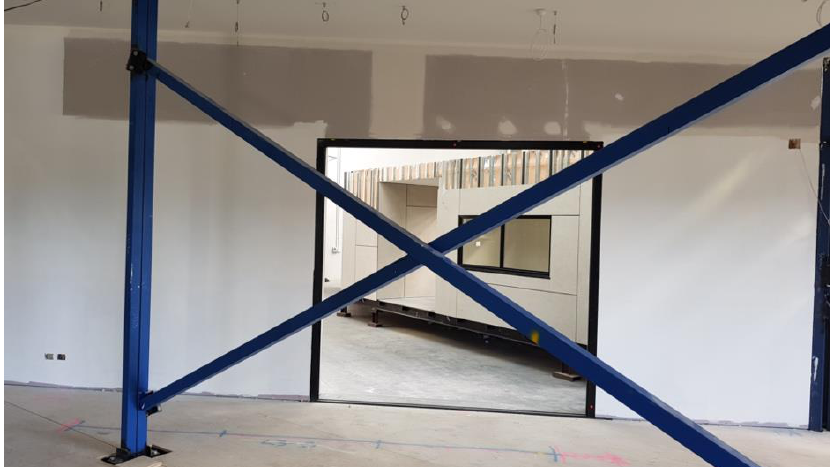
Figure 4. A temporary cross bracing applied between two temporary columns in a prefabricated volumetric module (all to be removed after